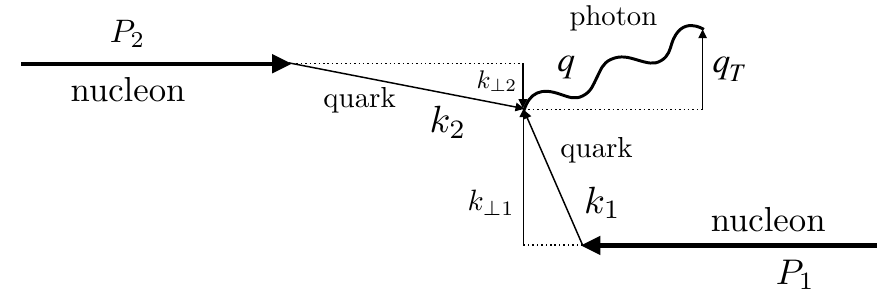
Figure 1 . Diagram displaying the relevant momenta involved in a Drell-Yan event. In a reference frame in which two colliding nucleons move along the z direction with 4-momenta P 1 and P 2 , a quark with 4-momentum k 1 and transverse momentum k ? 1 annihilates with a parton with 4-momentum k 2 and transverse momentum k ? 2 . A (virtual) photon (or Z ) is produced with 4-momentum q and transverse momentum q T = k ? 1 + k ? 2